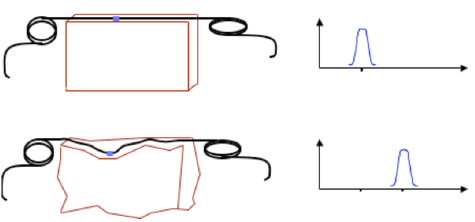
Figure 2. Wavelength variation as a function of the strain (image source: https://scienzapertutti.infn. it/schede-approfondimento/1669-fbg-cosa-sono-e-a-cosa-servono (accessed on 20 July